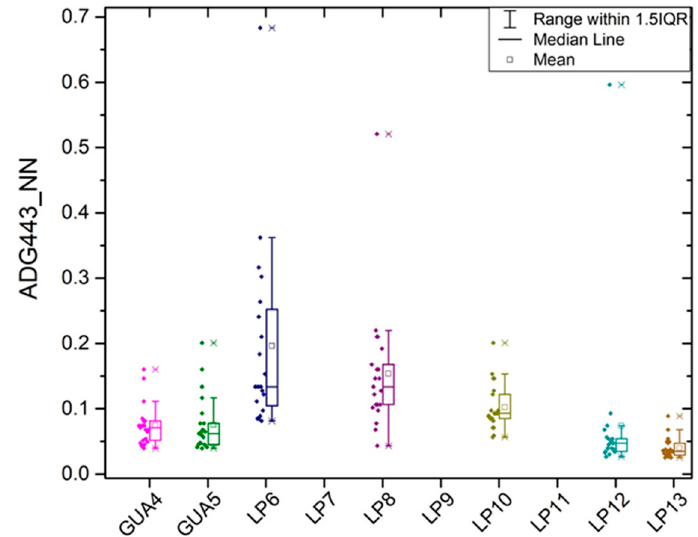
Figure 6. S3A OLCI Product ADG_443_NN from Sentinel 3A (EUMETSAT-Copernicus data) from July to December 2017 at selected sampling sites in southwestern, PR. The graph shows the range per site, median line, mean, data points, and extreme values.